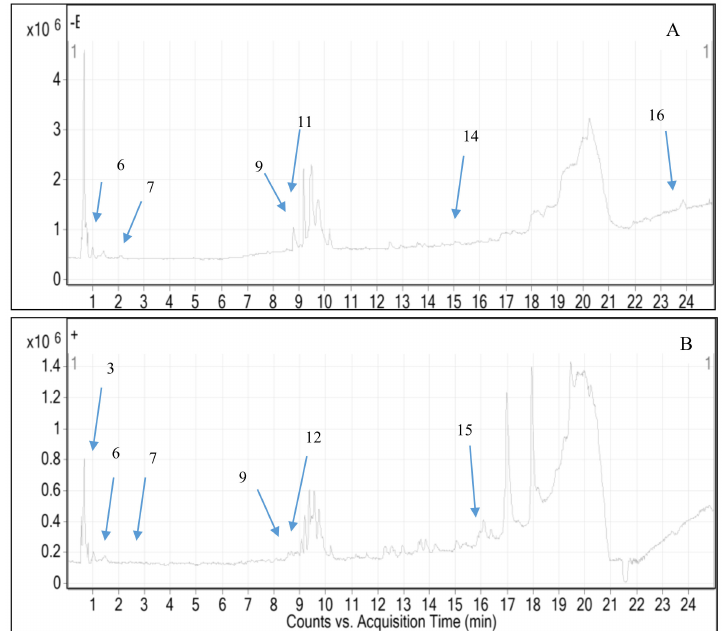
Figure 1. Total ion chromatogram from ethanol extract of M. odorata peel ( A ) negative mode and ( B ) positive mode.